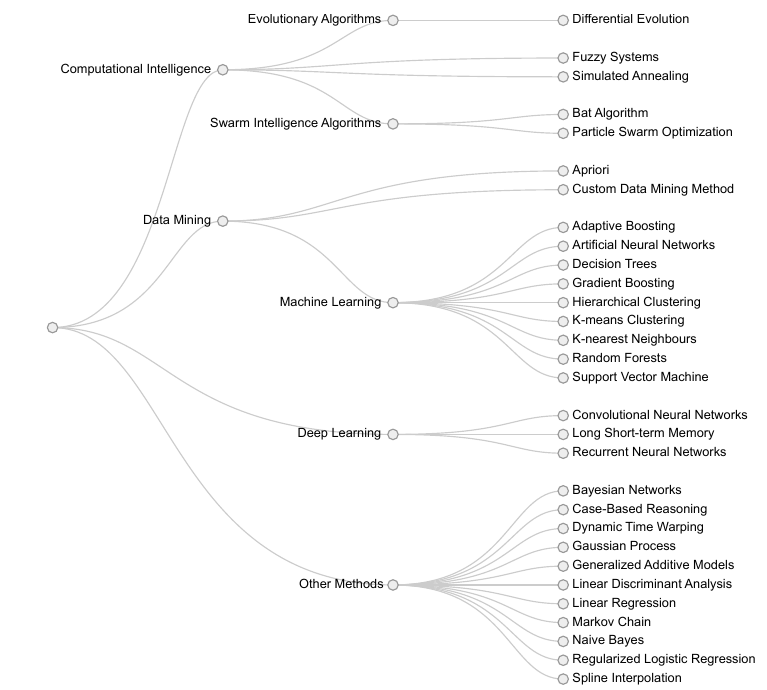
Figure 4. Taxonomy of methods used in smart sport